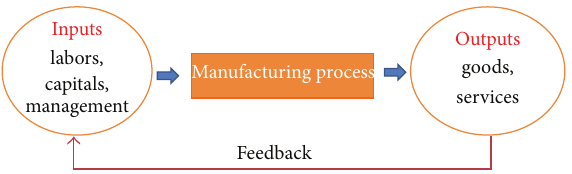
Figure 1: Variable and relationship of economical perspective productivity.